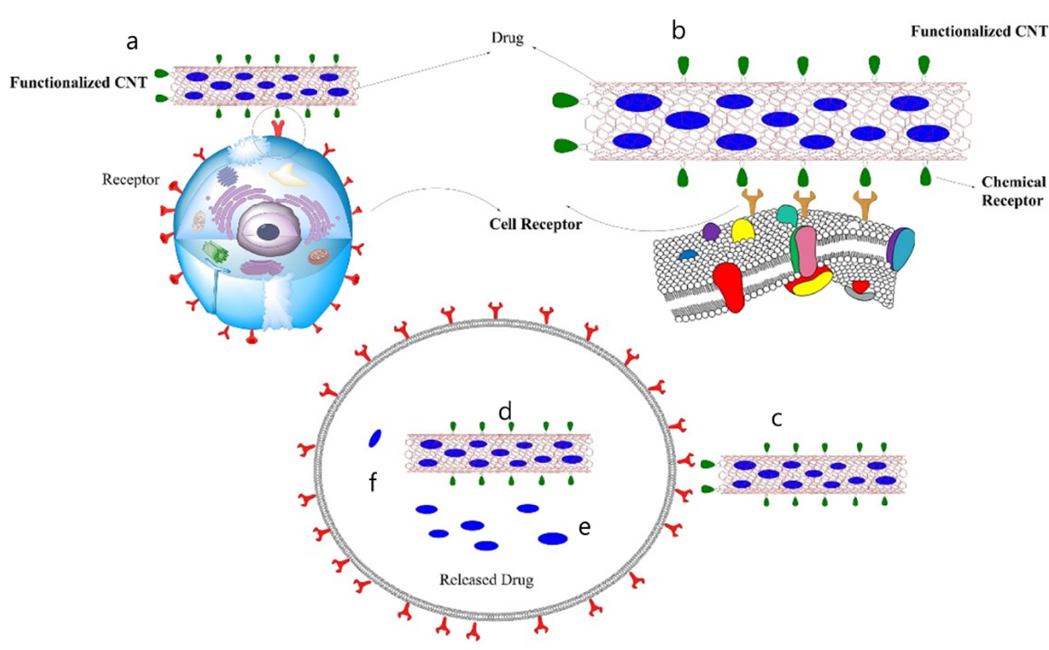
Figure 5. The drug delivery procedure is depicted graphically. ( a ) The surface of the carbon nanotube is linked to a chemical receptor and drugs are loaded inside, ( b ) the open end of the carbon nanotube is capped, ( c ) the drug-carbon nanotubes carrier is introduced into the body and reaches target cells via the chemical receptor on the carbon nanotubes surface, ( d ) the cell internalizes the carbon nanotubes via the endocytosis pathway, for example, ( e , f ) the cap is removed or biodegrades inside the cell, and then drugs are released.